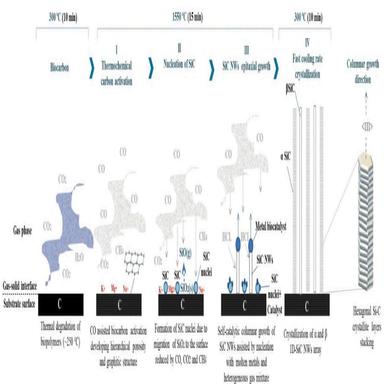
Schematic representation of the growth mechanisms of the self-assembled 1D SiC Nanostructures from Kelp precursor material. (I) Vapour-solid (VS). II) Vapour-Solid–liquid (VSL) nucleation. (III) Vapour-Liquid (VL) NWs growth from nucleated crystals exposed to mixed gases environment. (IV) Crystallization stage via fast cooling action.